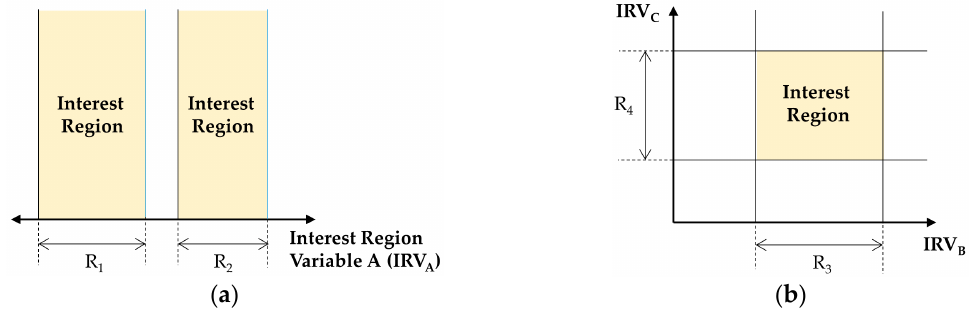
Figure 6. Examples of interest regions: ( a ) two regions defined from one interest region variable (IRV); ( b ) one region defined from two IRVs.